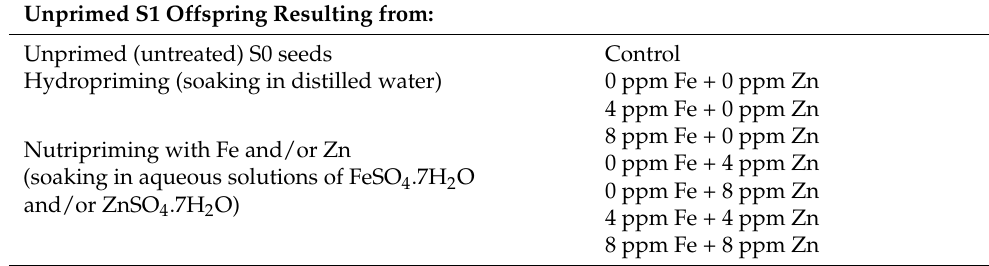
Table 4. Plant material used in this work: air-dried and unprimed S1 seeds that constitute the offspring of S0 seeds that were untreated (used as a control) and those that were hydroprimed and nutriprimed with Fe and/or Zn by